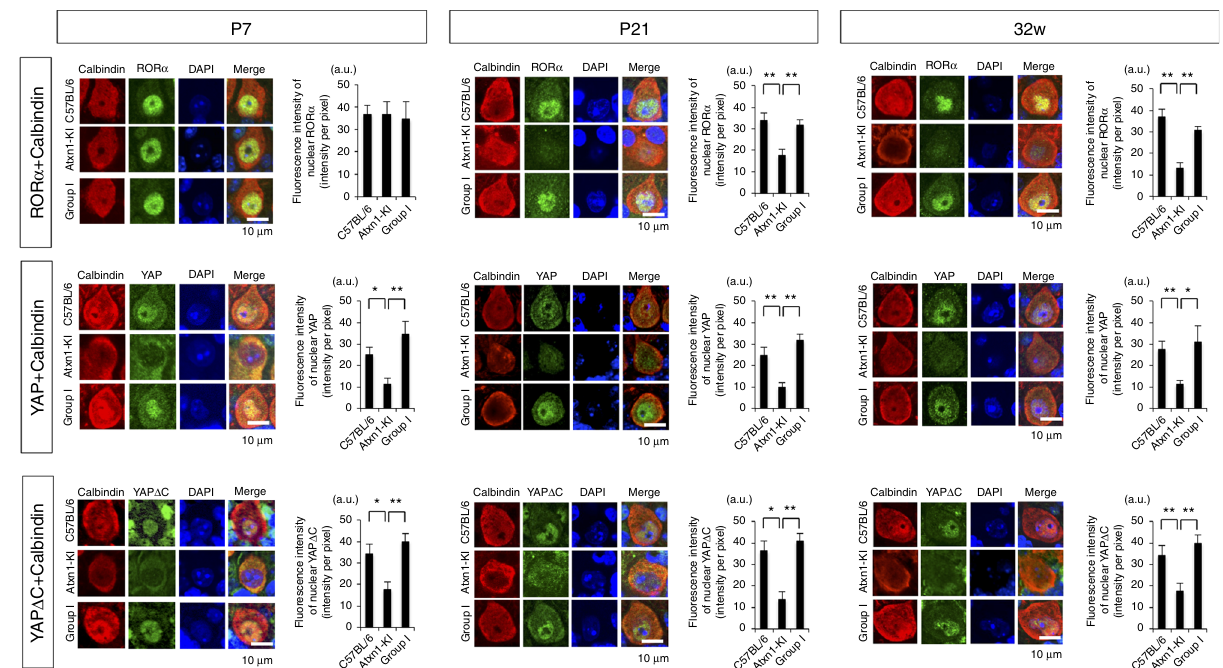
Fig. 9 Expression of YAP, YAPdeltaC, and ROR α in Purkinje cells in vivo. Purkinje cells were co-stained for Calbindin, a Purkinje cell-speci fi c marker, and ROR α , YAP, or YAPdeltaC in three groups of mice at P7, P21, and 32w. Graphs at right show quantitative analyses of ROR α , YAP, or YAPdeltaC signals in nuclei of Purkinje cells. Signal intensities were acquired from more than 100 Purkinje cells, randomly selected from 30 slides, with six mice in each group. One-way ANOVA with post hoc Tukey ’ s HSD test was used for statistical analysis. ** p <